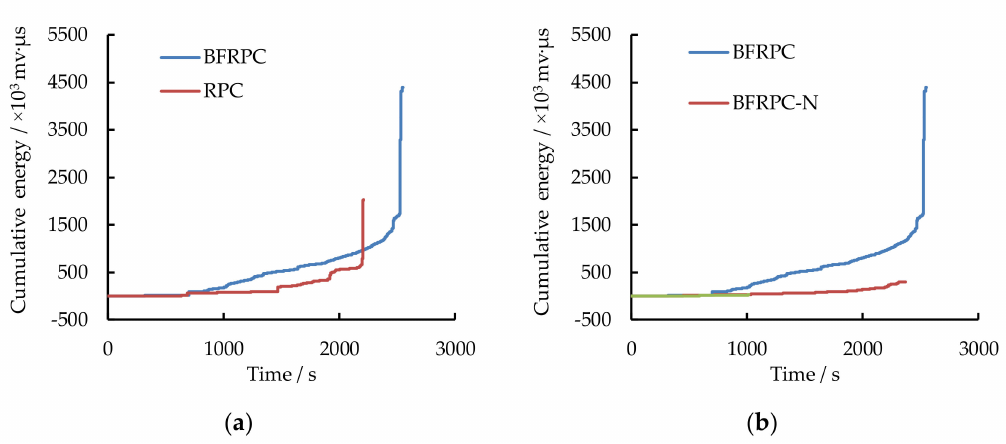
Figure 11. Influence of di ff erent factors on AE cumulative energy: ( a ) BF; ( b ) notch and interfacial